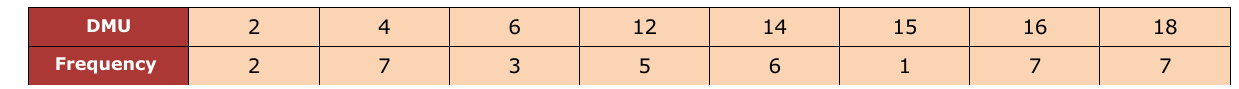
Table 10. Frequency of service as an efficiency